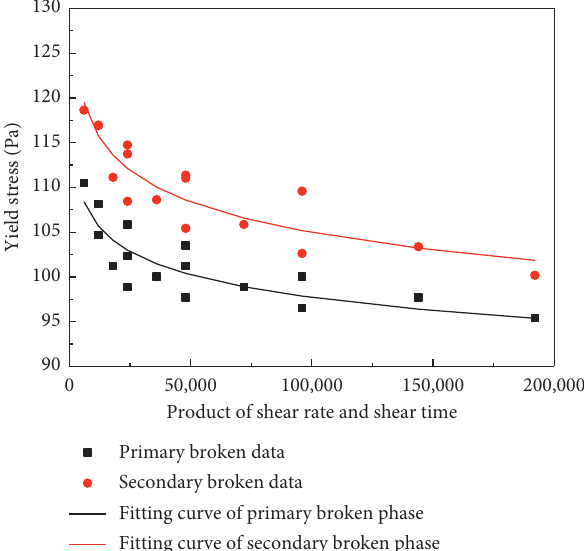
Figure 5: The variation of yield stress with the product of shear rate and shear time in the primary and secondary flocculation